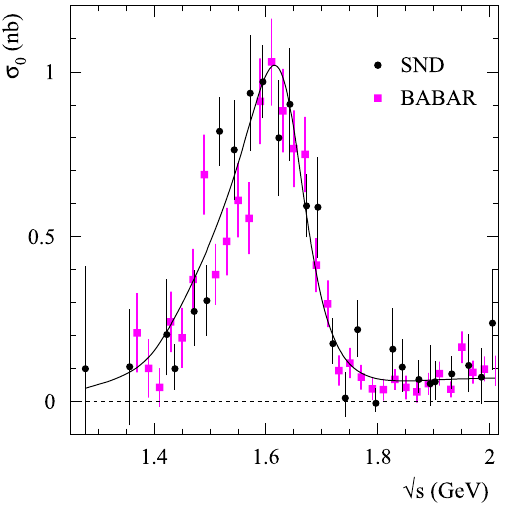
Fig. 8 The e + e − → K + K − π 0 Born cross section measured in this work (circles) compared with the BABAR [3] data (squares). The curve is the result of fit described in the text In Fig. 8, our measurement of the e + e − → K + K − π 0 cross section is compared with the result of the most precise previous measurement by BABAR [3]. Two measurements are consistent and comparable in